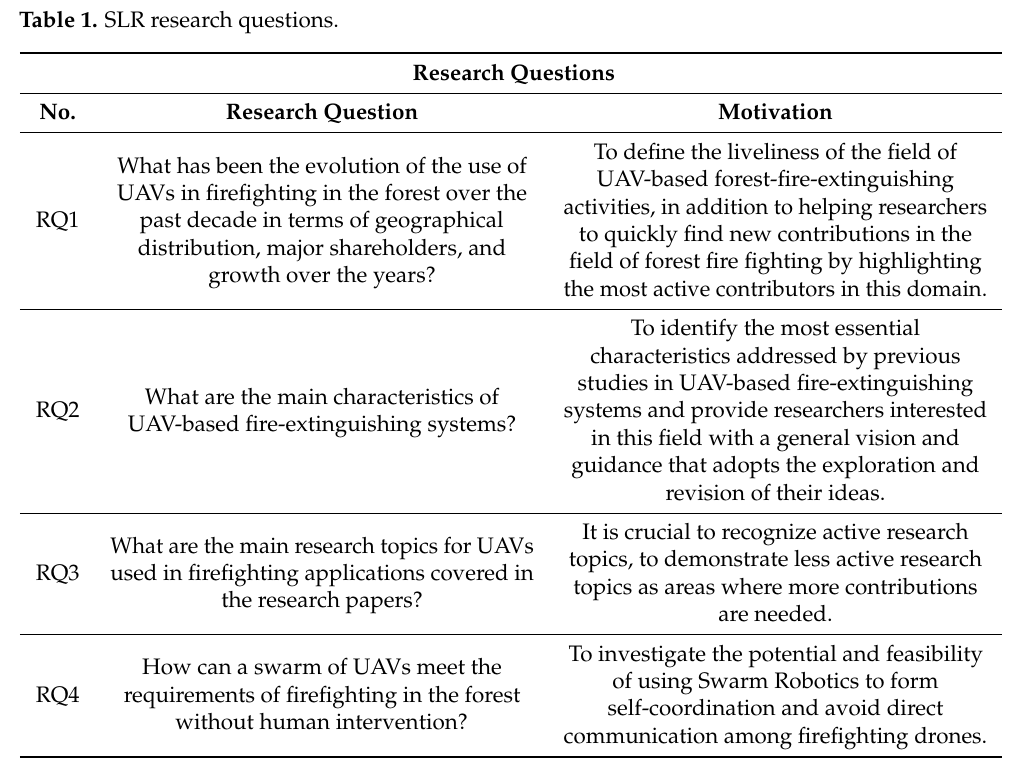
Table 1. SLR research questions.